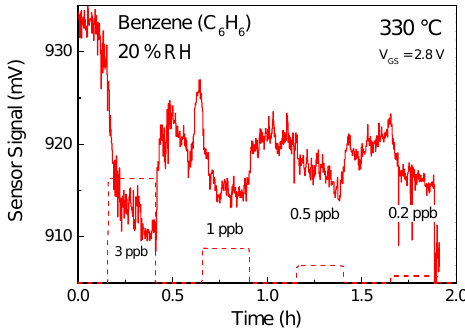
Figure 11. Detection limit for formaldehyde (CH 2 O), benzene (C 6 H 6 ) , and naphthalene (C 10 H 8 ) as a function of relative humid- ity. In the case of C 10 H 8 , it is only possible to say that the detection limit is below 0.5ppb, since our gas mixing system does not supply C 10 H 8 concentrations below 0.5ppb.